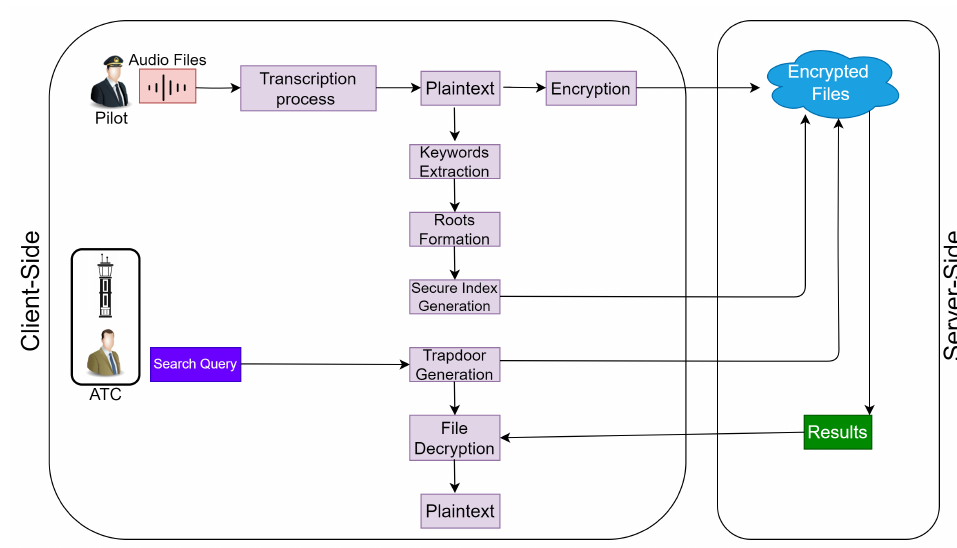
Figure 4. The system schematic flow.